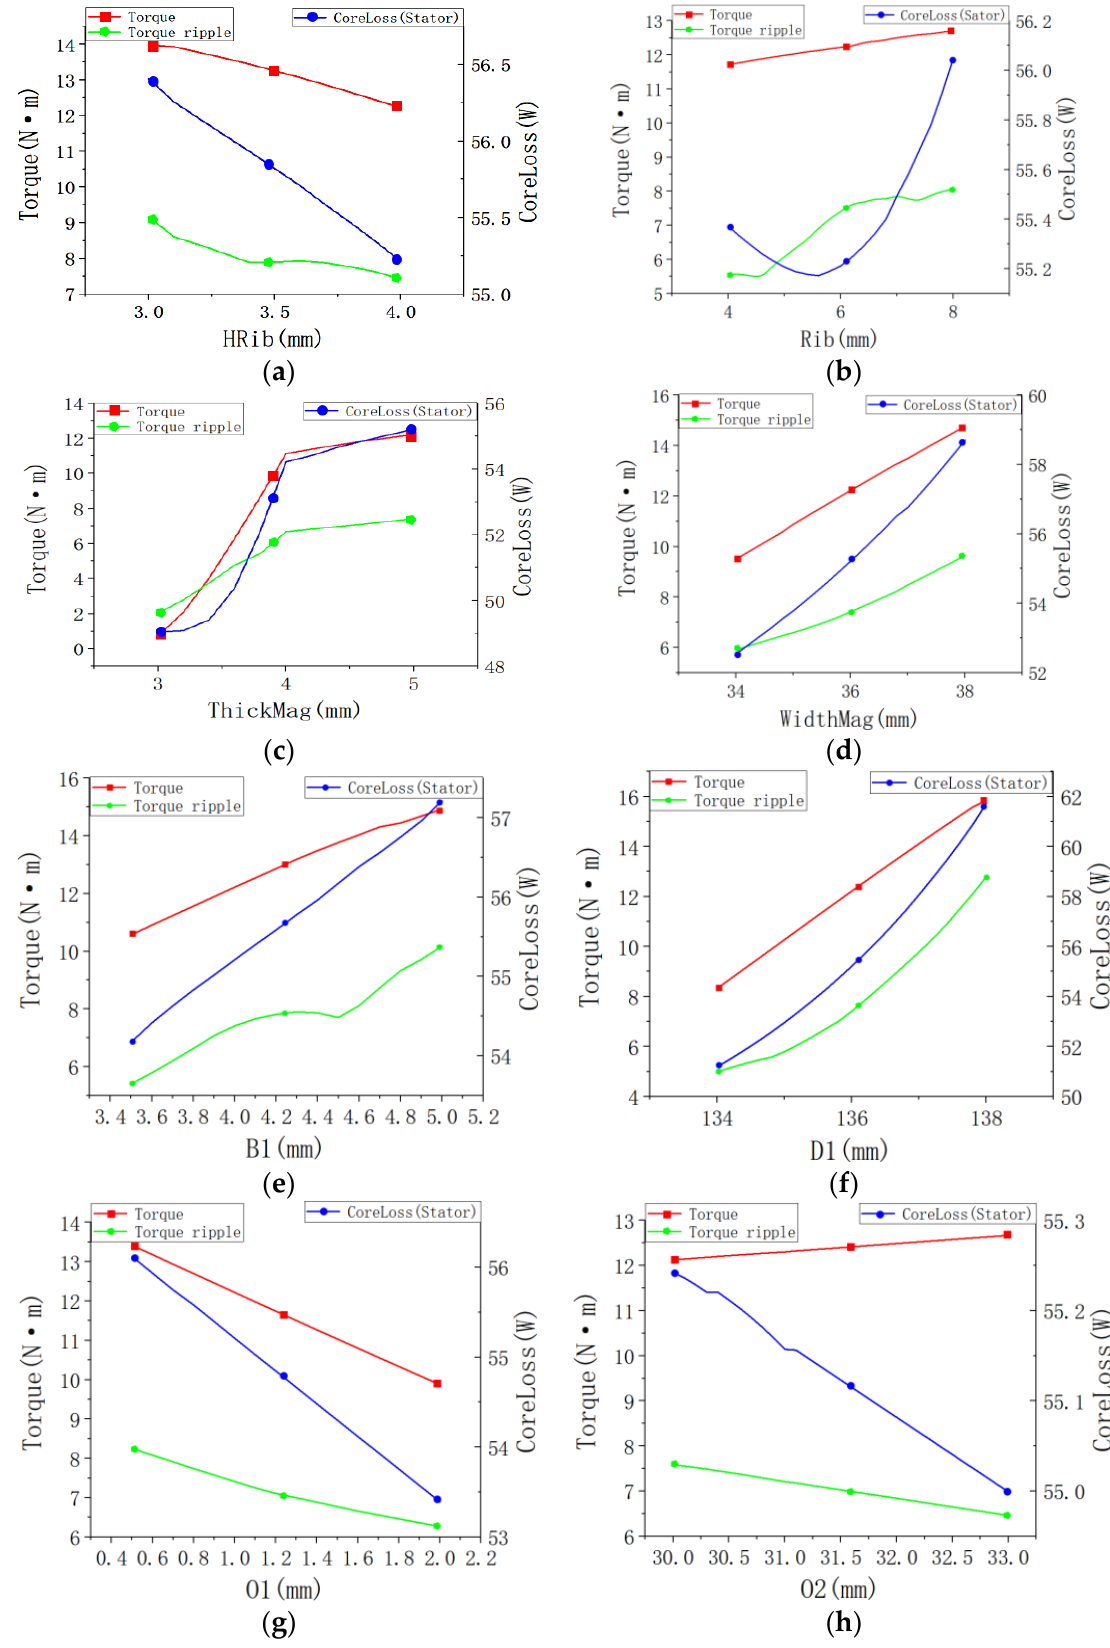
Figure 3. ( a – h ) Effects of optimized parameters on output torque (torque ripple) and core loss.